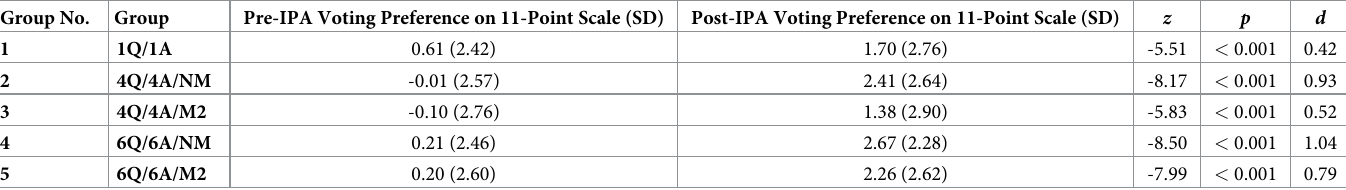
Table 7. Experiment 3: Pre-IPA vs. Post-IPA voting preferences on 11-point scales. Group No.